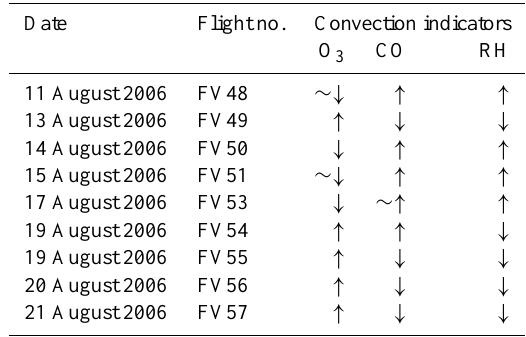
Table 3. Convection indicators variations for F-F20 flights. ↓ : de- creasing mixing ratios, ↑ : increasing mixing